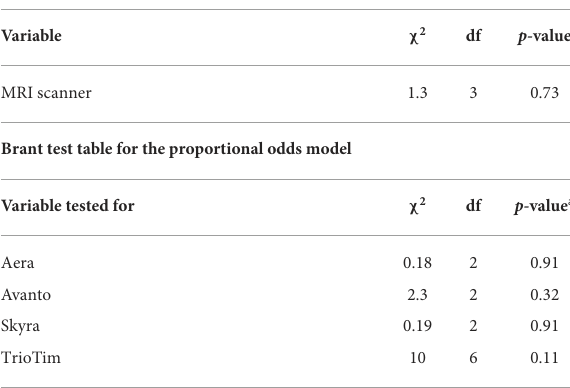
TABLE 3 Results of the proportional odds model analysis for the evaluation of the distribution of the STO score among four MR scanners.